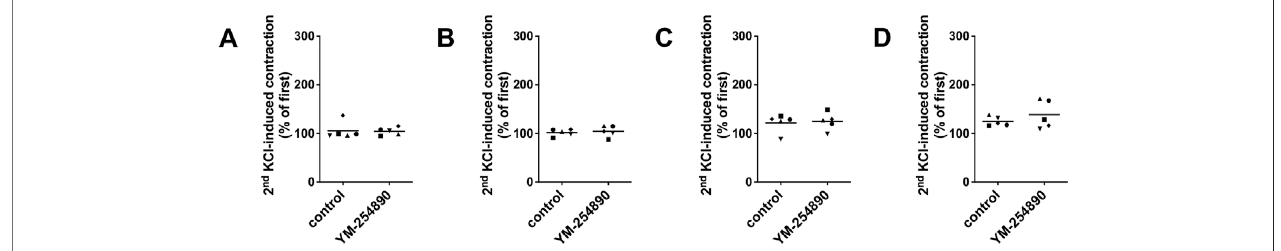
FIGURE 6 | Contractions by highmolar KCl (80 mM) were induced in human prostate (A) and detrusor tissues (B) , and in porcine coronary (C) and interlobar arteries (D) . Contractions by highmolar KCl were induced by addition of 2 M KCl solution to normal Krebs-Henseleit solution in organ bath chambers (80 mM), before construction of frequency or concentration response curves (followed by washout before construction of curves, and before addition of YM-254890 or equal amount of solvent). To assess effects of YM-254890 or DMSO, contractions by KCl were induced before and after application of YM-254890 (30 nM) or equal amount of solvent (DMSO, 10 μ l/ml) in the same sets of experiments, and the second KCl-induced contraction was expressed as percentage of the fi rst KCl-induced contraction. Shown are single values from each experiment, based on double determination. In any case, the effect of KCl is graphed as means and uses individual symbols for experiments performed with the same tissue, using tissues from n = 5 different patients or animals for each experiment and data